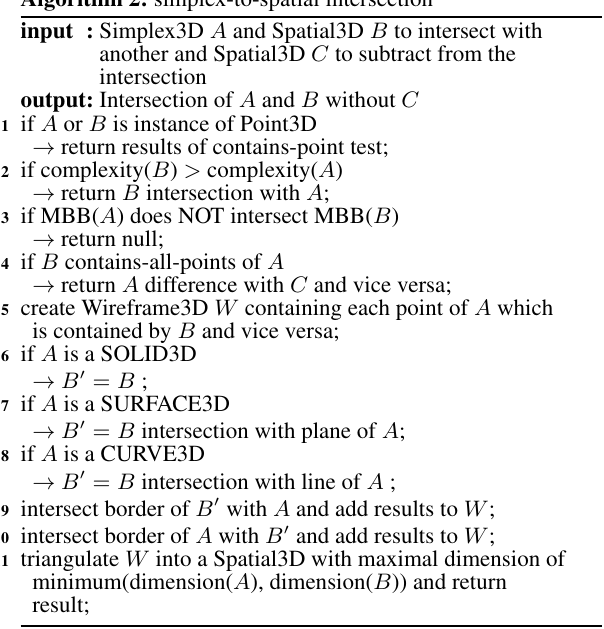
Algorithm 2: simplex-to-spatial intersection